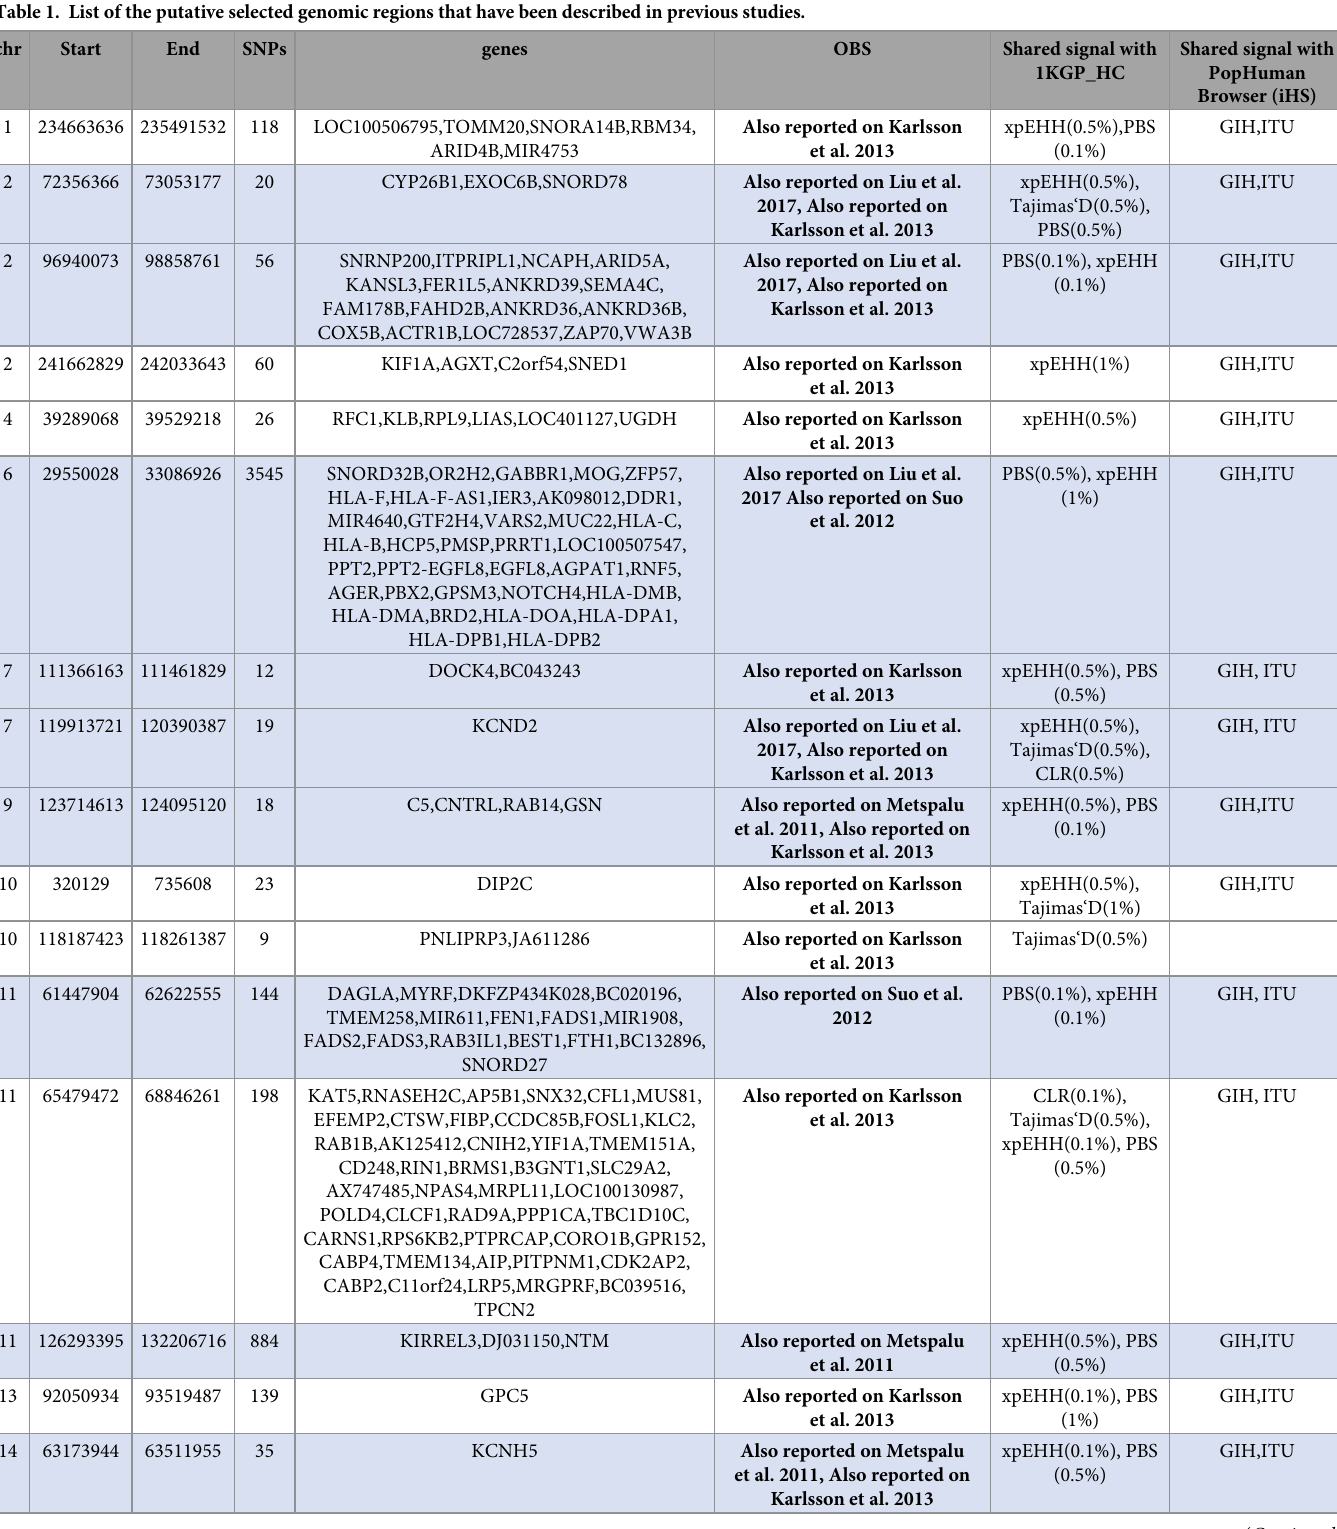
Table 1. List of the putative selected genomic regions that have been described in previous